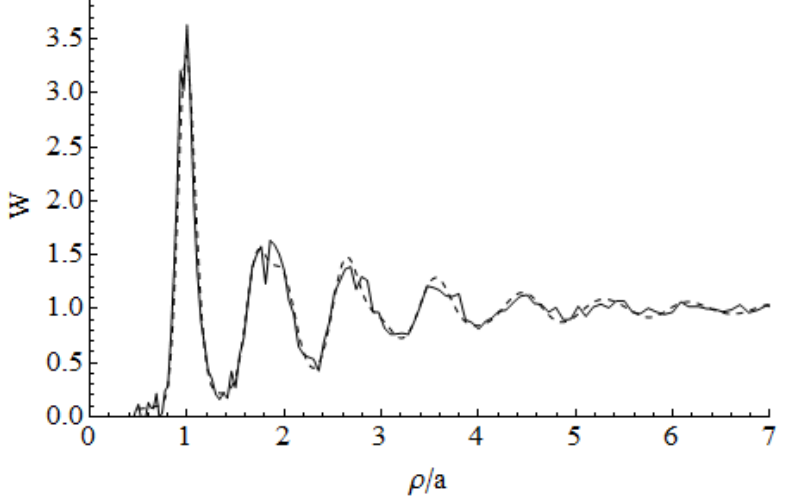
Figure 3. Radial distribution function of pores in porous aluminum oxide: experimental sample (solid curve) and our calculation (dashed curve).